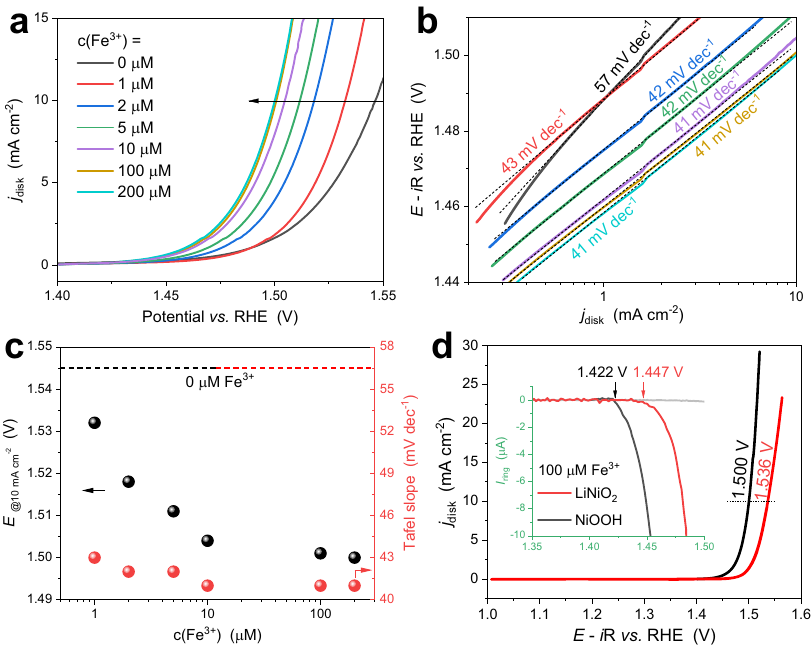
d Comparison of the Fe 3+ promotional effects on LiNiO 2 and NiOOH. Note that 100 µ MFe 3+ reachesthesaturatedconcentrationofFe(OH) 4 - (thepredominantFe 3+ species in alkaline solution) 70